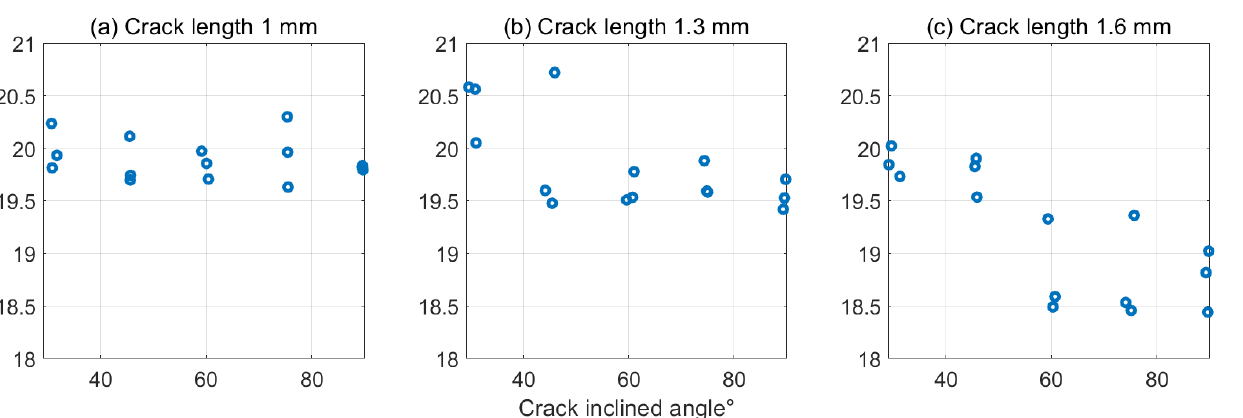
Figure 9. First-order resonance amplitude for inclined cracks with different angles. ( a ) 1 mm crack length. ( b ) 1.3 mm crack length. ( c ) 1.6 mm crack length. 3.4. Regression Modelling between the Inclined Crack and Torsional Spring Stiffness As a result of the discussion in Sections 3.2 and 3.3, one crucial point to keep in mind is that the local stiffness in the oblique crack area and the beam’s dynamic response sig- nificantly depend on the number of breaking ABS filaments. Coincidentally, this parame- ter can be quantified in relation to 𝜑 the crack depth ratio directly. This conclusion is consistent with the super small p -values between 𝜑 , 𝑓 and 𝑈 in Table 2. Therefore, a regression model between the crack depth ratio 𝜑 and equivalent tor- sional spring stiffness 𝑘 was developed, as shown in Equation (7) and Figure 10, with a 62.76% R-square value.